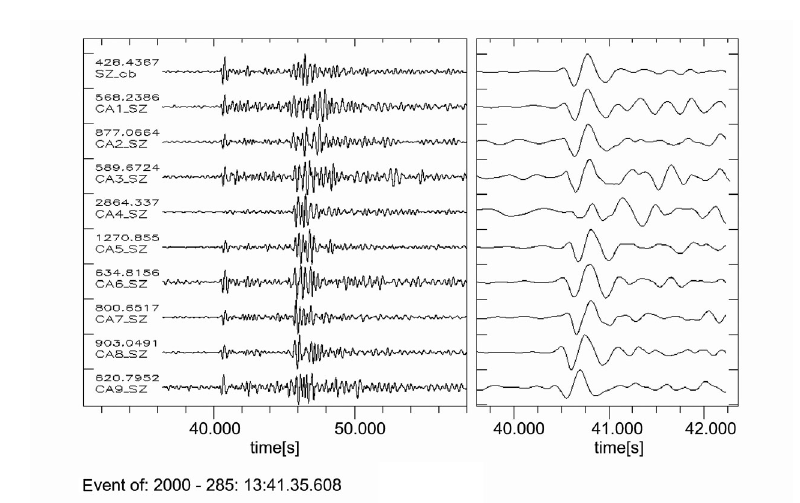
Fig. 9. Vertical seismograms (CA1_SZ-CA9_SZ) and corresponding beam (upper trace SZ_cb), calculated for the apparent velocity and backazimuth, determined by the f - k analysis of fig. 8. The right side shows a blow-up of the Pg